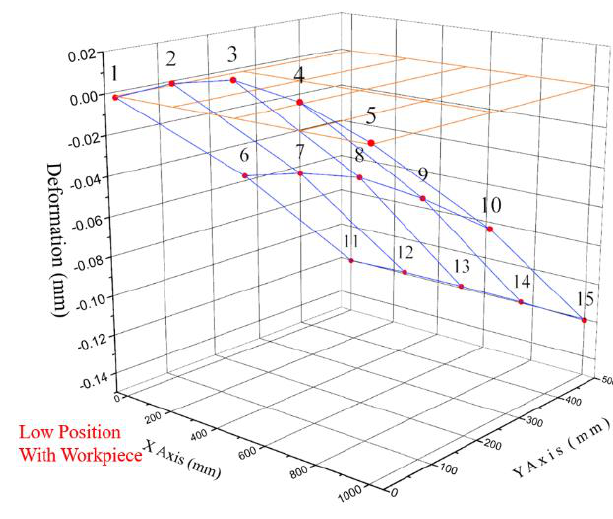
Figure 9. Schematic diagram of the low point of the spindle with load.